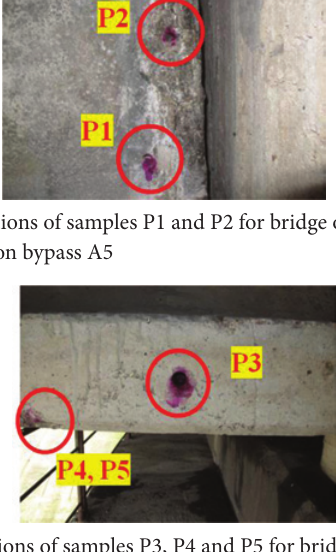
fig. 15. Signs of leaking and deteriorated membrane